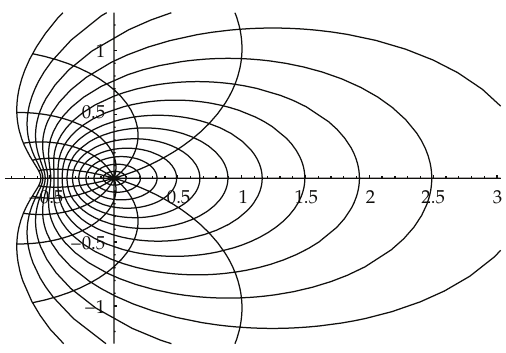
Figure 6: The image of f (cid:3) z (cid:4) in Example